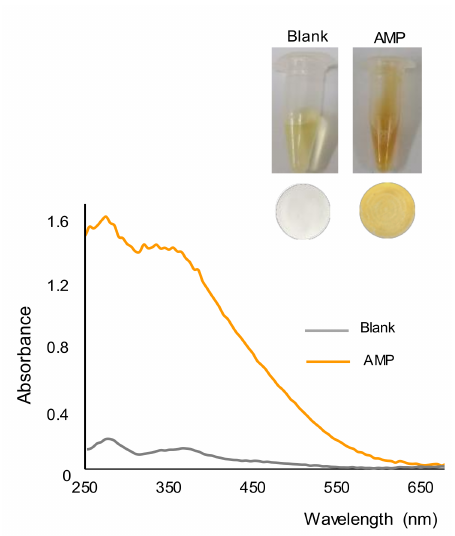
Figure 1. Pictures of the working solutions and membranes obtained for a blank (water) and a solution containing 500 ppm of AMP, and diffuse reflectance spectra of the